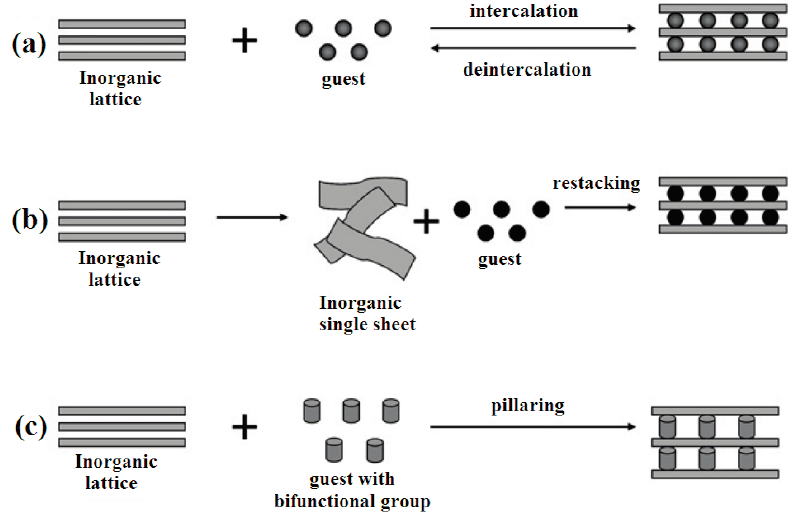
Figure 2. Reaction routes to incorporate biomolecules into layered nanomaterials ( a ) intercalation; ( b ) exfoliation-restacking; ( c ) pillaring reaction. Reprinted with permission from [41] (Copyright 2009 Royal Society of